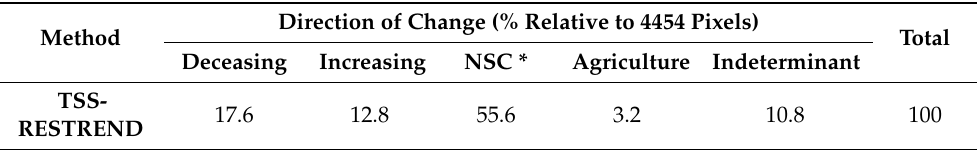
Table 2. A summary of the identified direction of change in productivity based on the TSS- RESTREND method in New Mexico during the 1982–2015